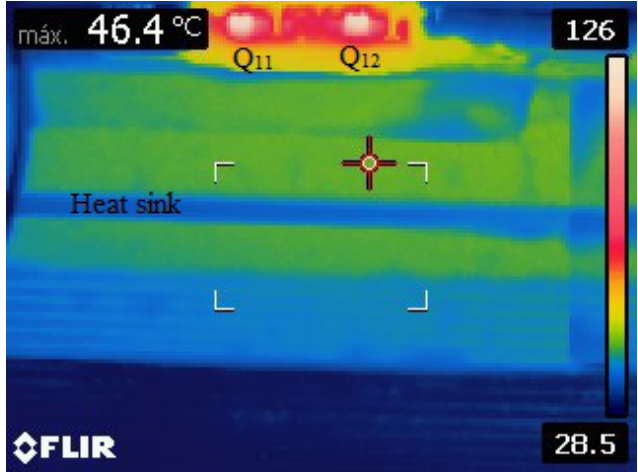
Figure 19. Thermal image for the inverter operating at nominal power, this lateral view shows only Q 11 and Q 12 on phase